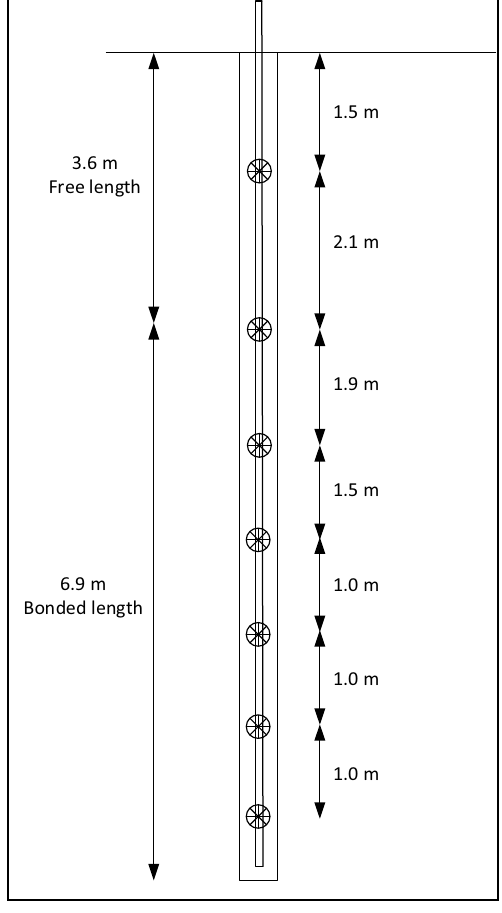
Figure 5: Strain gauges location along the anchor length for anchor